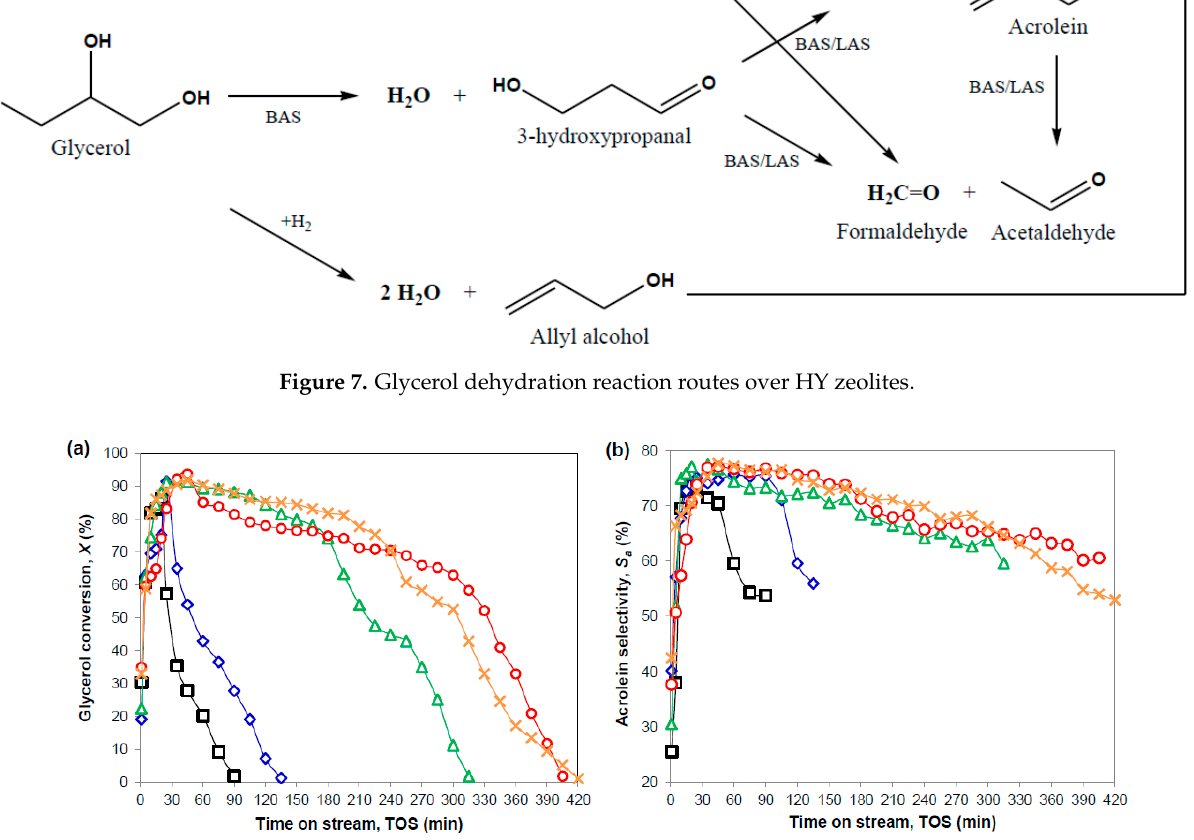
Figure 7. Glycerol dehydration reaction routes over HY zeolites.